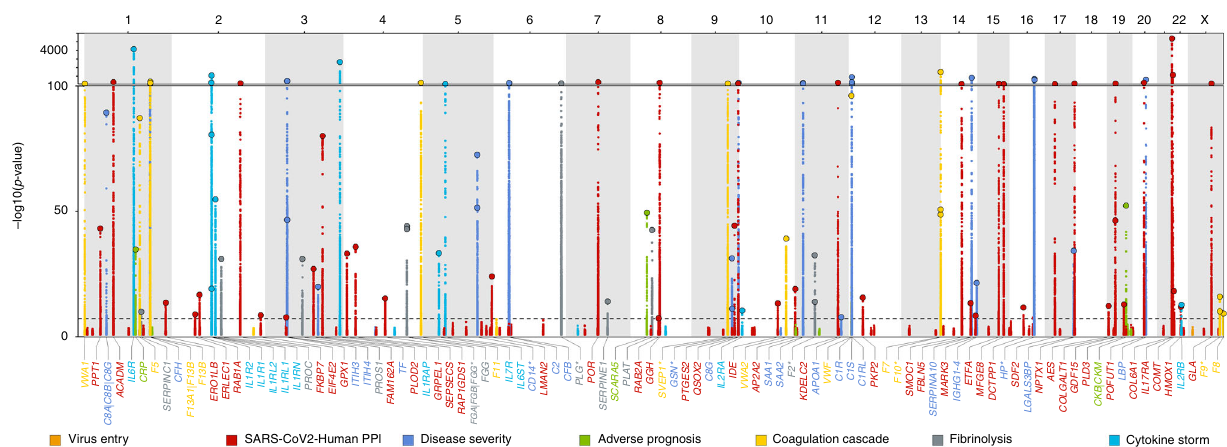
Fig. 2 Manhattan plot of cis -associations statistics (encoding gene ±500kb) for 179 proteins. The most signi fi cant regional sentinel protein quantitative trait loci (pQTL) acting in cis are annotated by larger dots for 104 unique protein targets (dashed line; p < 5 × 10 − 8 ). Starred genes indicate those targeted by multiple aptamers ( n =